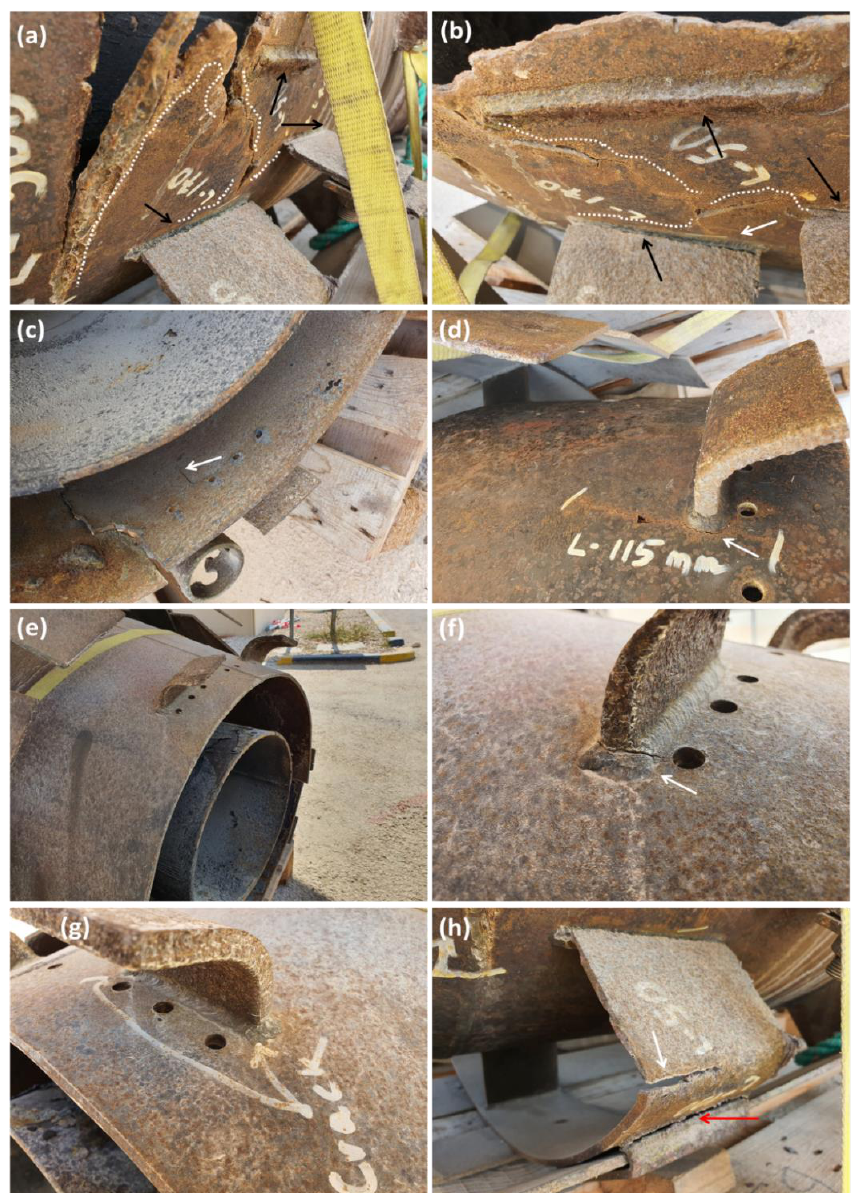
Figure 12. A detailed study of the root cause of the failure region in the vicinity of the joints ( a – c,f,h ) The most critical sections that failure took place ( d,g ) welding at the vicinity of holes ( e ) the upper part of the flare tip .